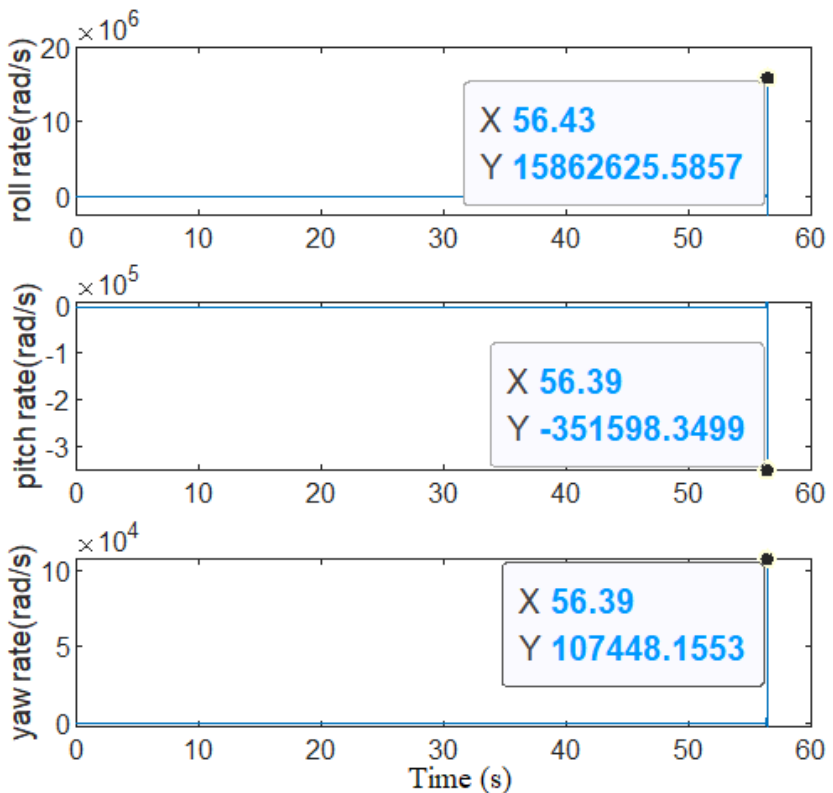
Figure 26. Multiplication fault: control result of angular rate without sensor